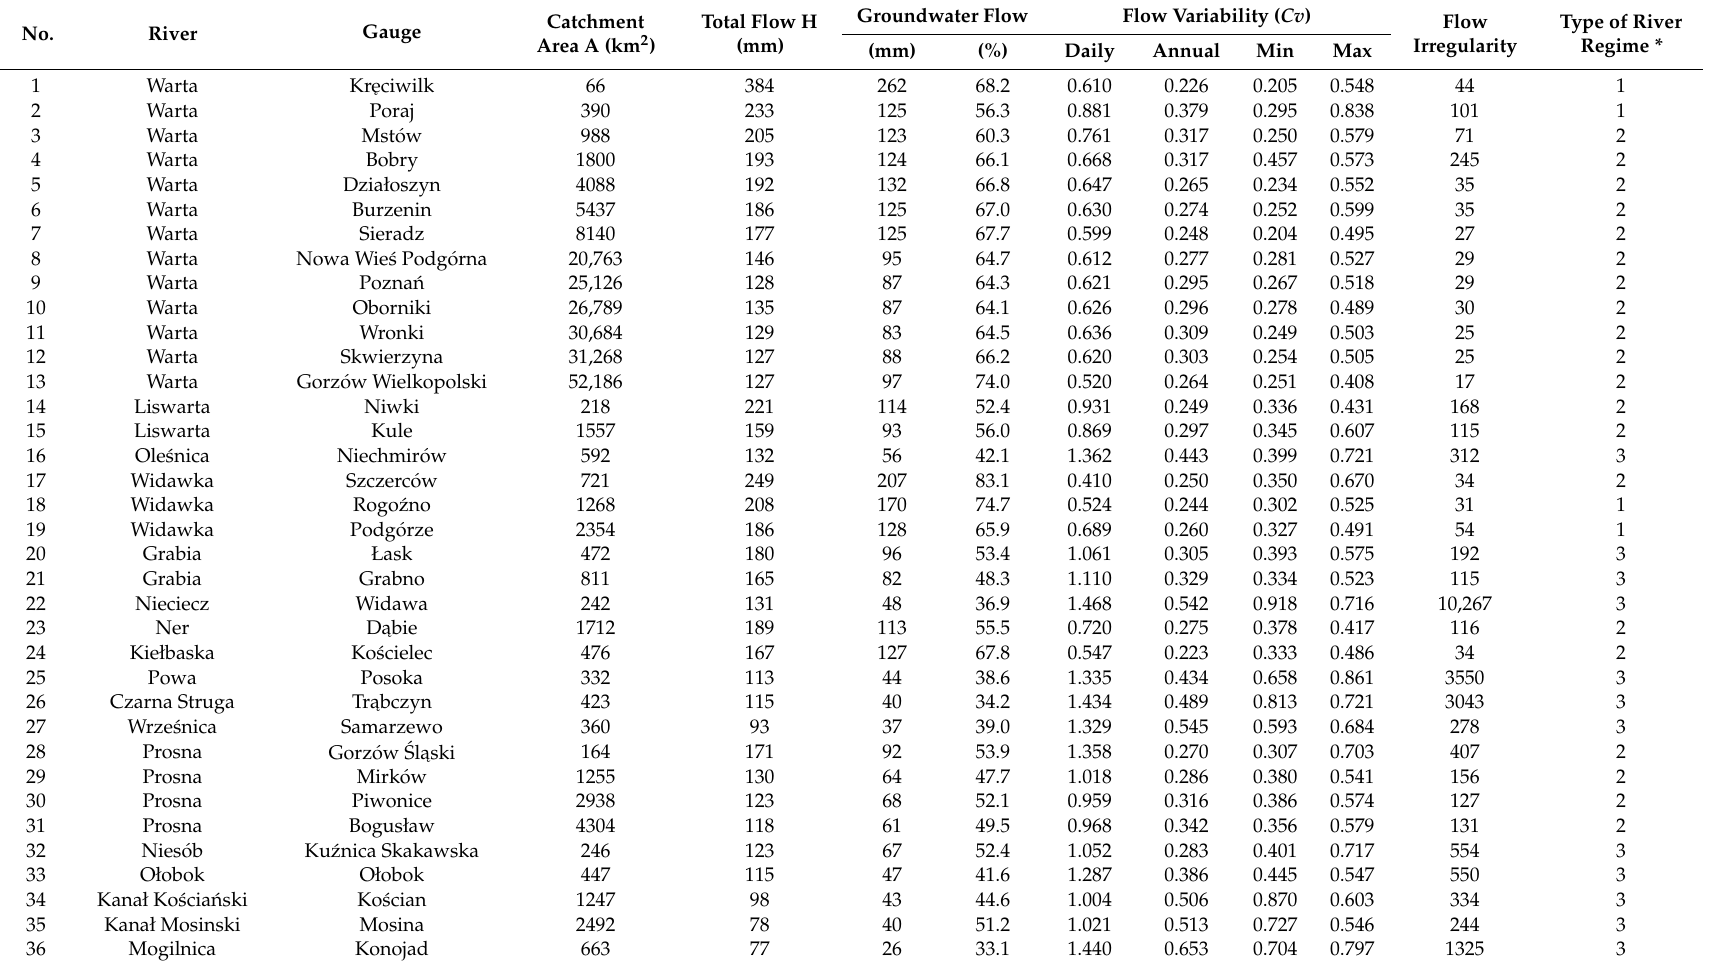
Table 1. Major characteristics and flow regime of the analyzed rivers in the Warta River catchment in